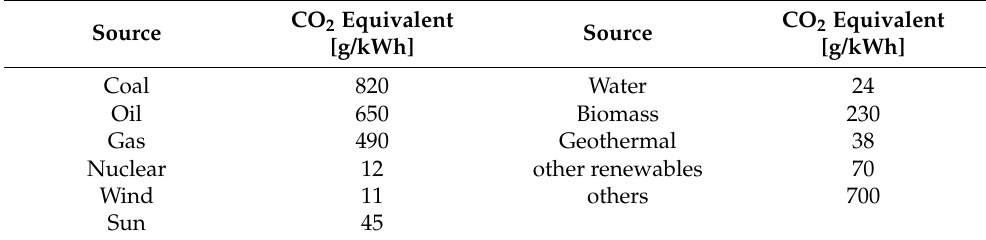
Table 2. Different sources for electricity production and the corresponding CO 2 release in